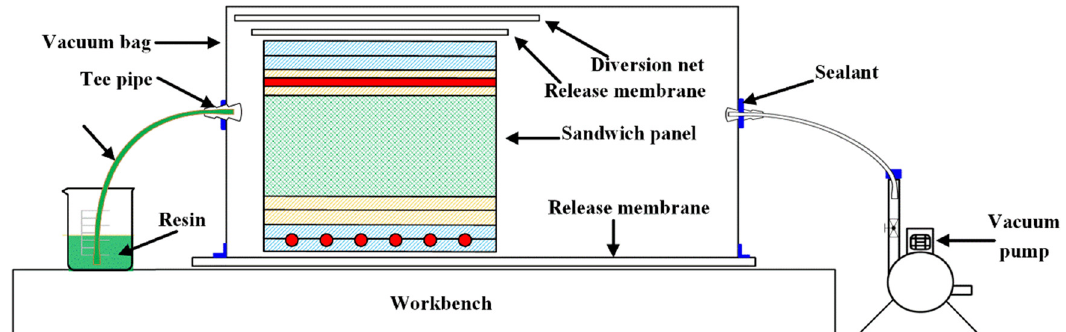
Figure 2: Schematic plot of the VARI process.